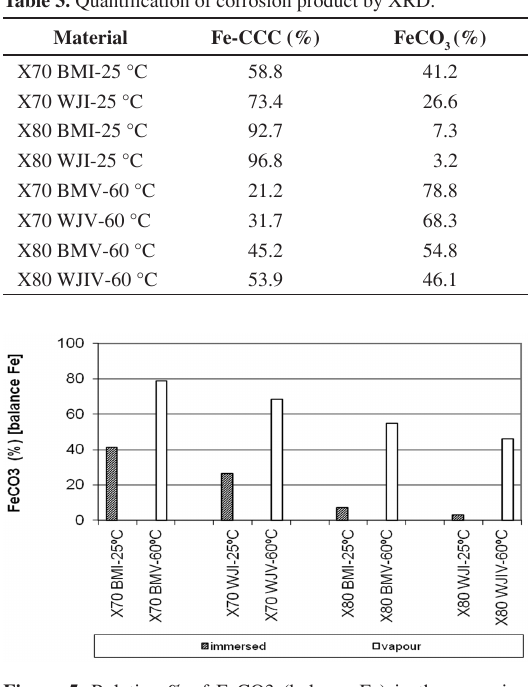
Figure 5. Relative % of FeCO3 (balance Fe) in the corrosion products as determined from the XRD data (BM-base metal, WJ- welded joint, I-immersed, V-vapour).